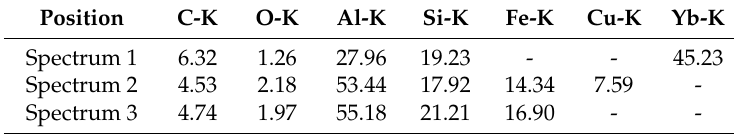
Table 2. Chemical composition of the indicated point in Figure 7b (wt %).